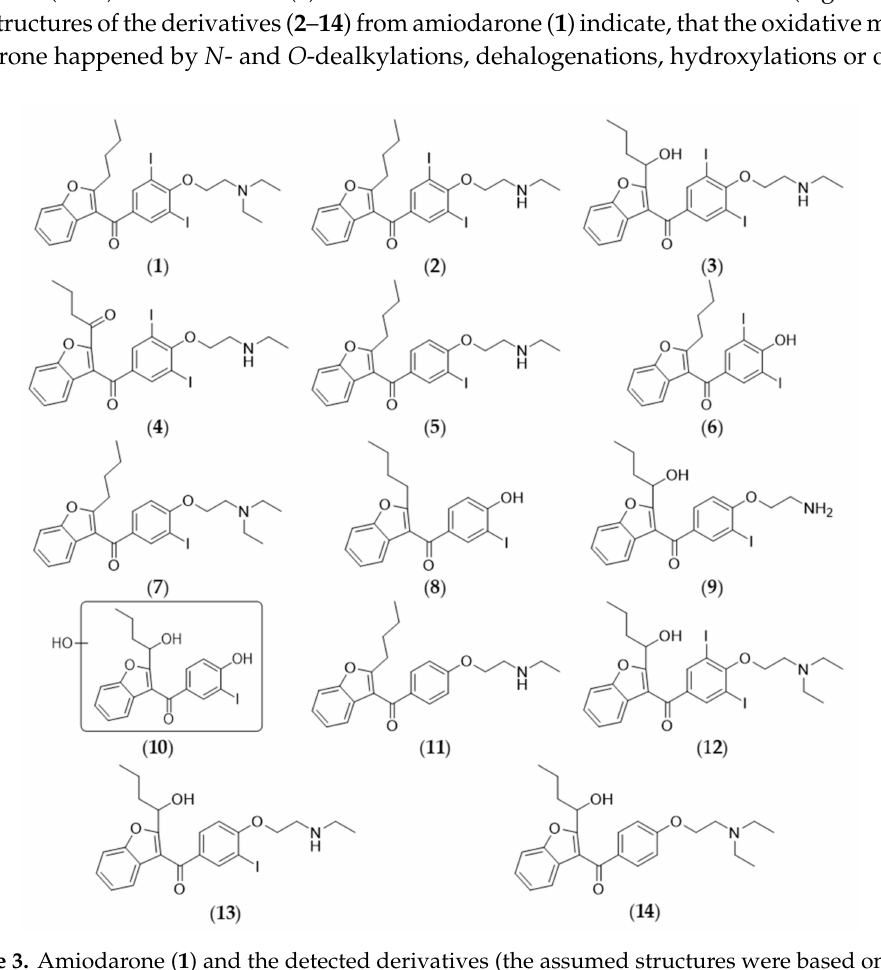
Figure 3. Amiodarone ( 1 ) and the detected derivatives (the assumed structures were based on their HRMS signal) of amiodarone ( 2 – 14